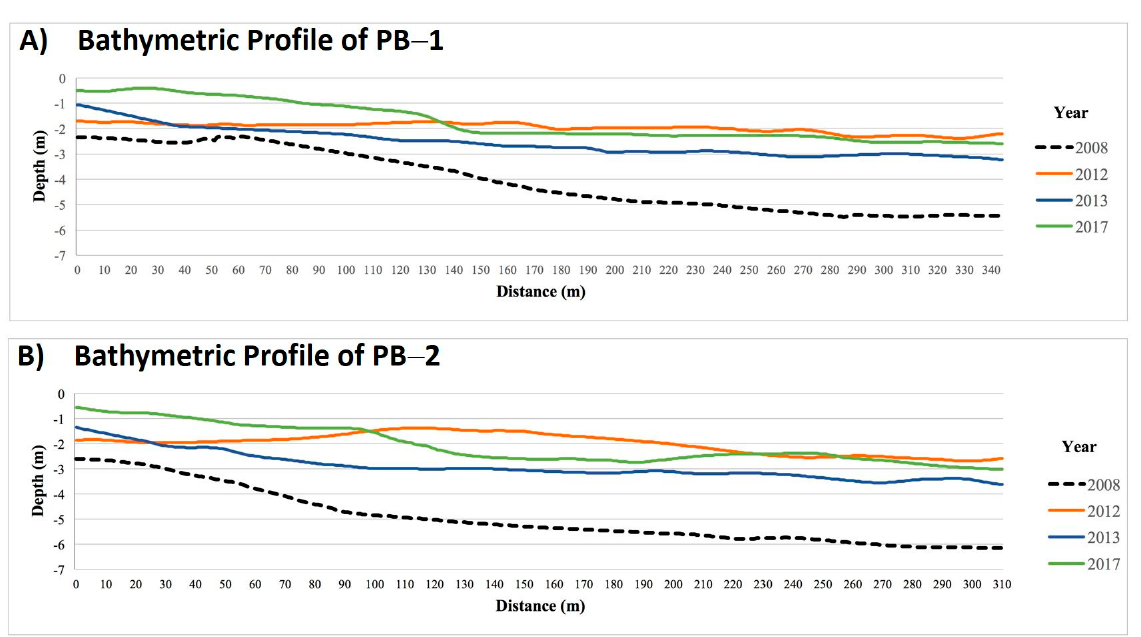
Figure 7. Bathymetric profiles pre- and postearthquake, Tubul Bay. The bathymetric profiles surveyed in the period of 2008–2013 were compared. In both profiles ( A , B ), a decrease can be observed in the depths with an average of − 0.45 in profile PB-1. See Figure 2A for the location of each profile.